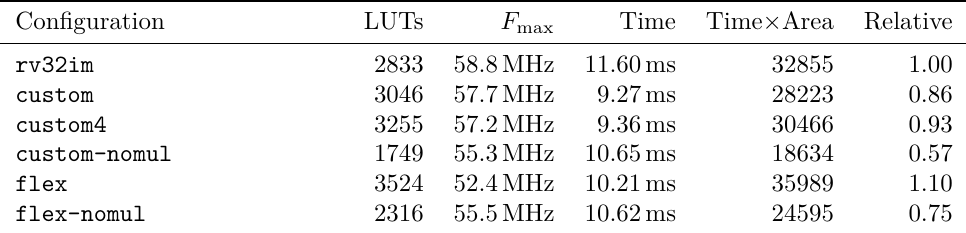
Table 7: Xilinx Artix-35T Time-Area performance of NewHope1024 decapsulation for a DSP-less implementation with varying core